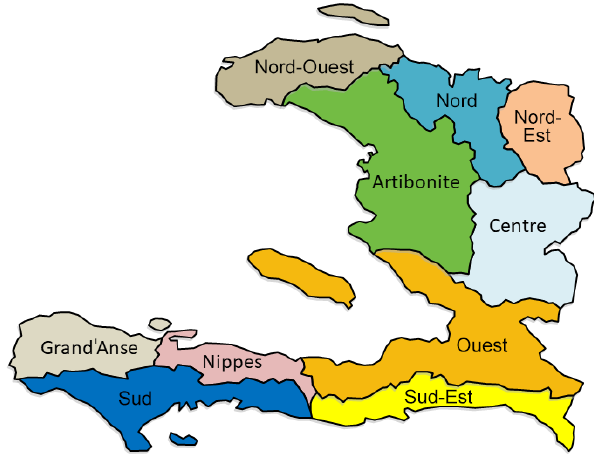
Figure 2. Map of Haiti